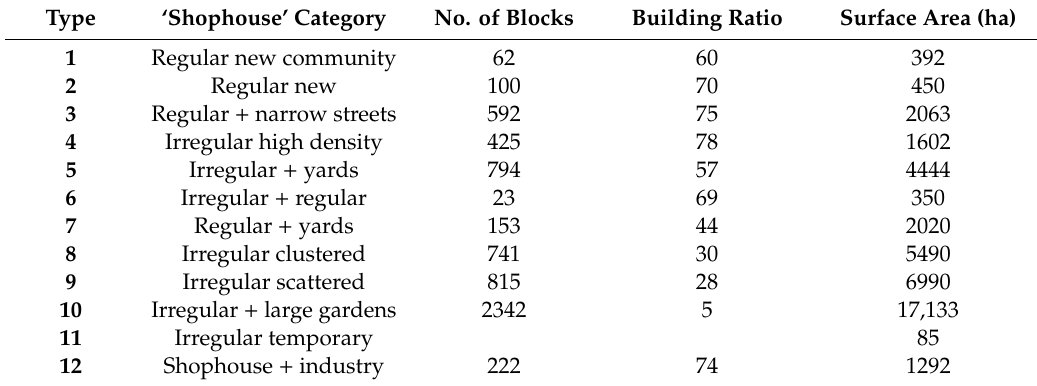
Table 1. Summary of urban structure pattern types of ‘shophouses’ (source: Downes & Storch, [30]).